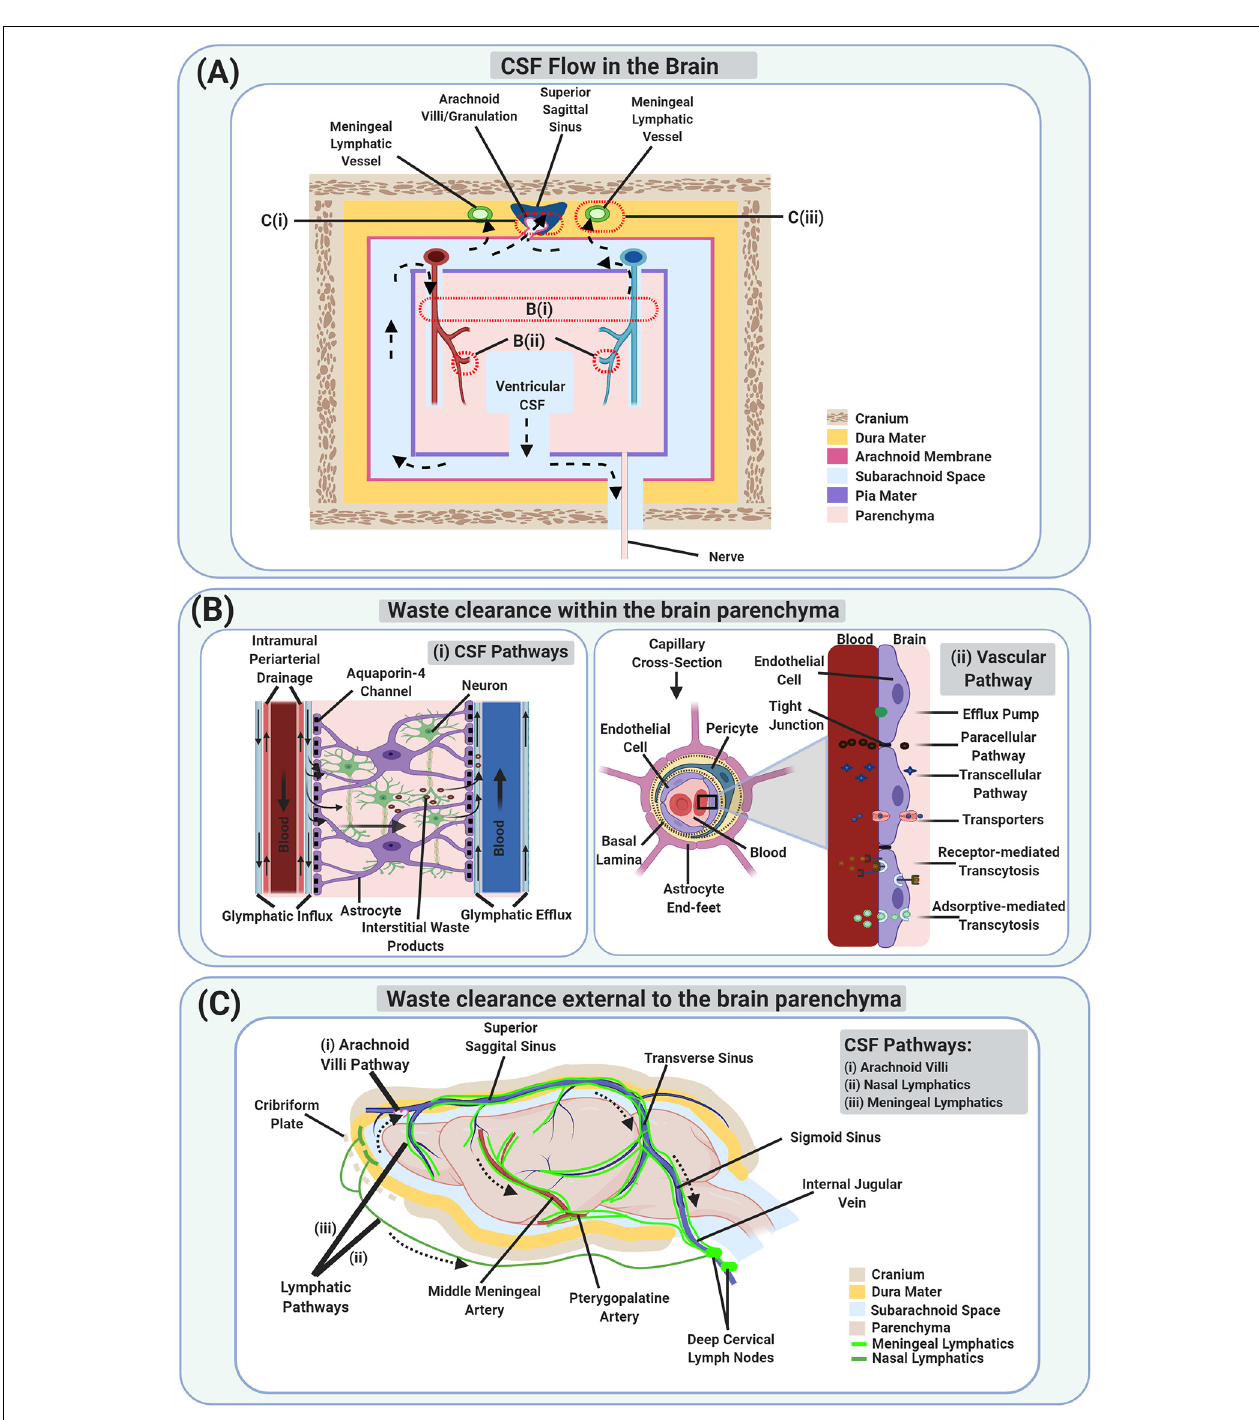
FIGURE 1 | Schematic illustration of Waste Clearance (WC) in the brain. (A) Schematic model of cerebrospinal fluid (CSF) flow which is involved in brain WC, both within (B) and external to the brain parenchyma (C) . Dotted arrows show the movement of CSF from the ventricular compartments to the subarachnoid space, entering the brain parenchyma via periarterial spaces, getting mixed with interstitial waste products as well as interstitial fluid (ISF), entering the perivenous space, and then draining via perineural spaces and lymphatics. The waste products also reach the vascular compartments directly via the blood-brain barrier (BBB) and indirectly via CSF exiting through the arachnoid villi/granulations. (Bi) A magnified schematic image of the glymphatic system and intramural periarterial drainage (IPAD) pathways involved in WC within the brain parenchyma. (Bii) A magnified schematic image of the vascular pathway via the BBB at the capillary level. (C) A schematic image of the CSF pathways involved in brain WC via the arachnoid villi (Ci) , and lymphatic pathways [including the nasal lymphatics (Cii) , and the meningeal lymphatics (Ciii) ].